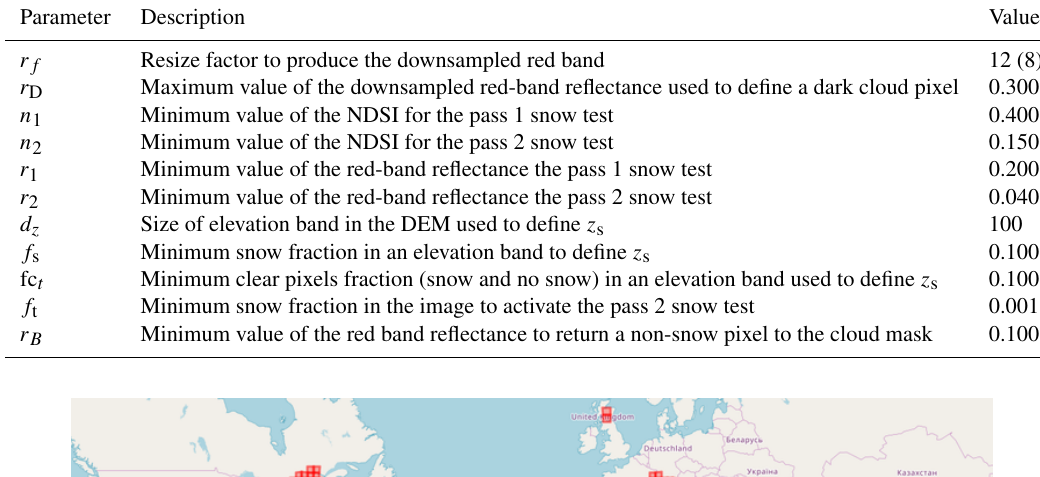
Table 1. LIS algorithm parameters description and default values for Theia’s L2A Sentinel-2 (and Landsat-8) products.